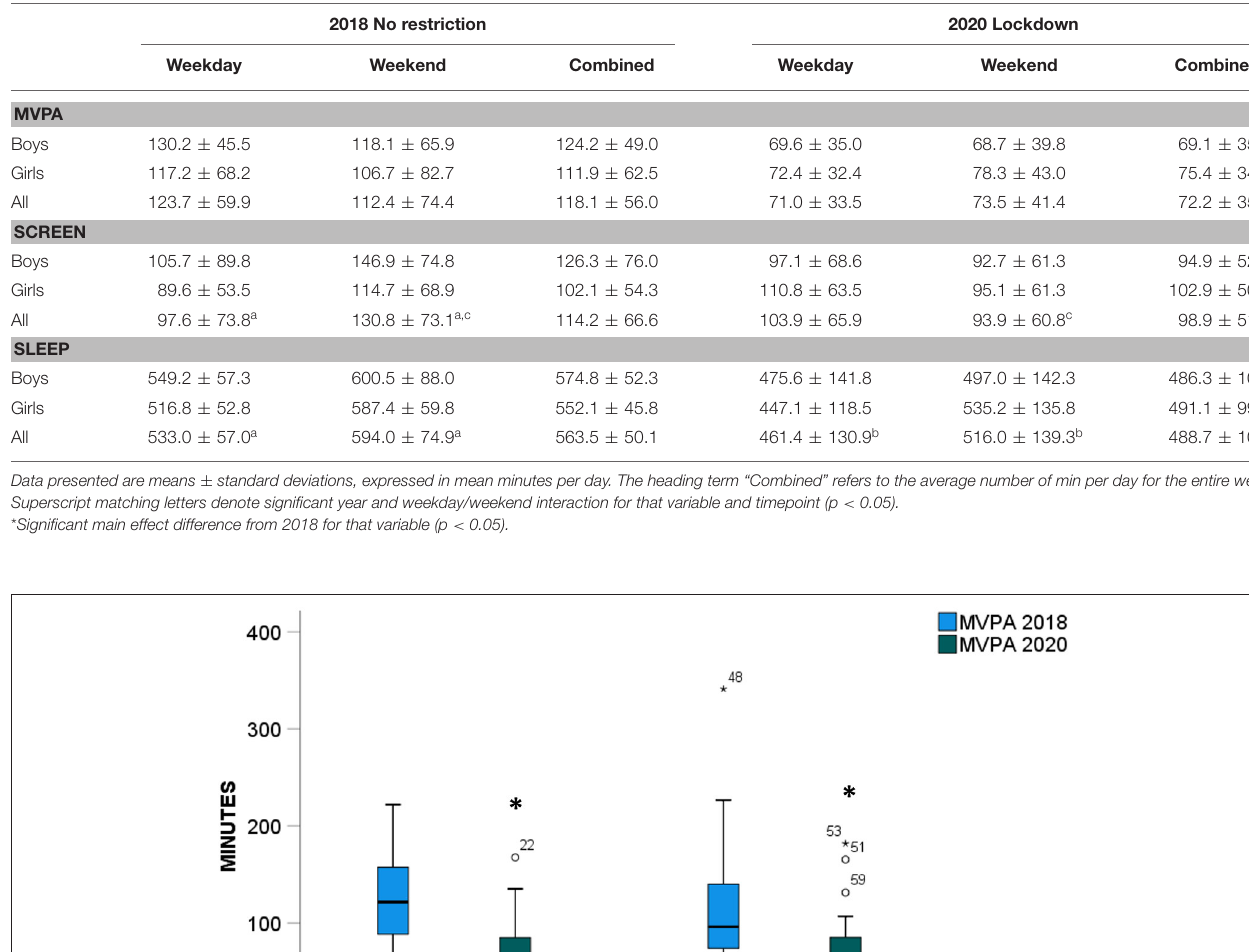
TABLE 2 | Phase 1 repeated-measures differences in moderate-to-vigorous physical activity (MVPA), screen time minutes and nocturnal sleep duration sampled in October 2018 and April 2020, stratified between boys and girls.